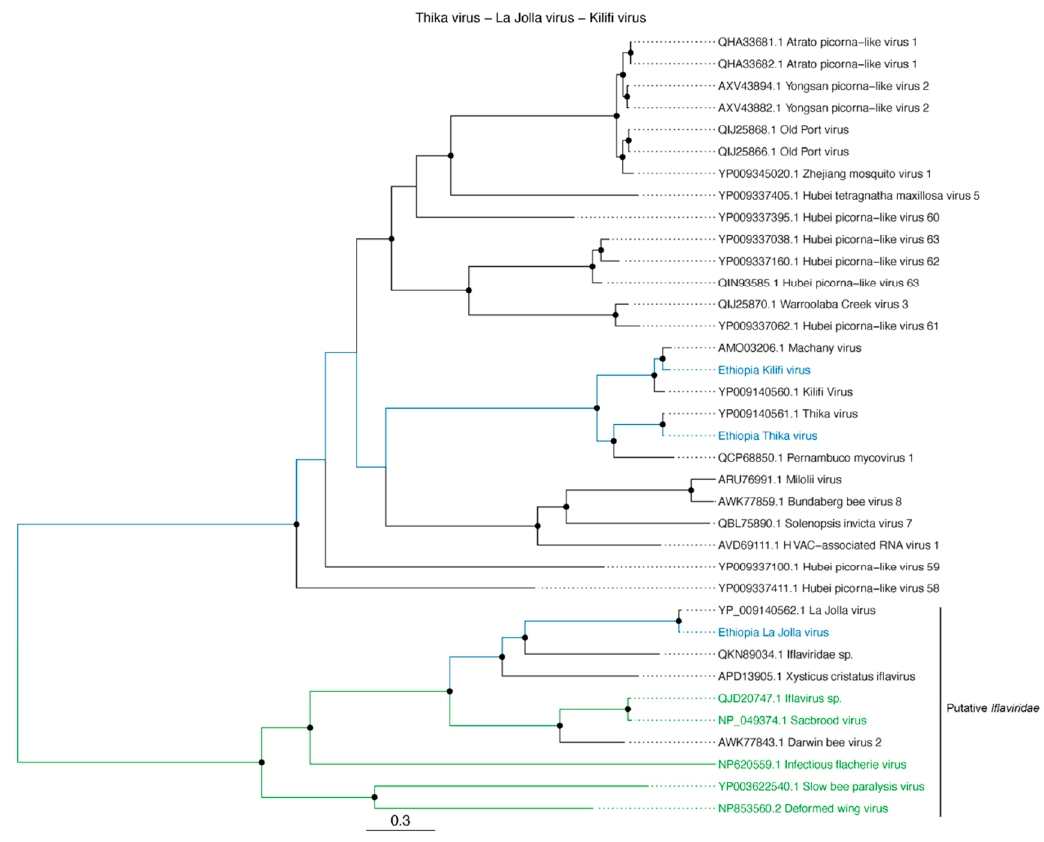
Figure 6. Midpoint-rooted phylogenetic tree based on near-complete genome alignments (on amino acid level) of the retrieved Ethiopian strains of KiV, Thika virus (ThV), and LJV. The putative Iflaviridae clade is highlighted. Assigned Iflaviridae members are indicated in green. Retrieved viruses in this study are indicated in blue. Boostrap values above 70% are indicated as black circles on their respective nodes.